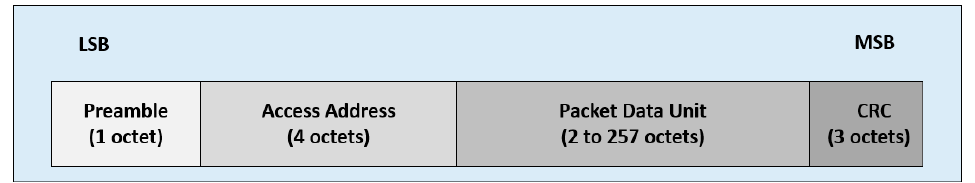
Figure 5. Bluetooth Low Energy (BLE) packet structure.